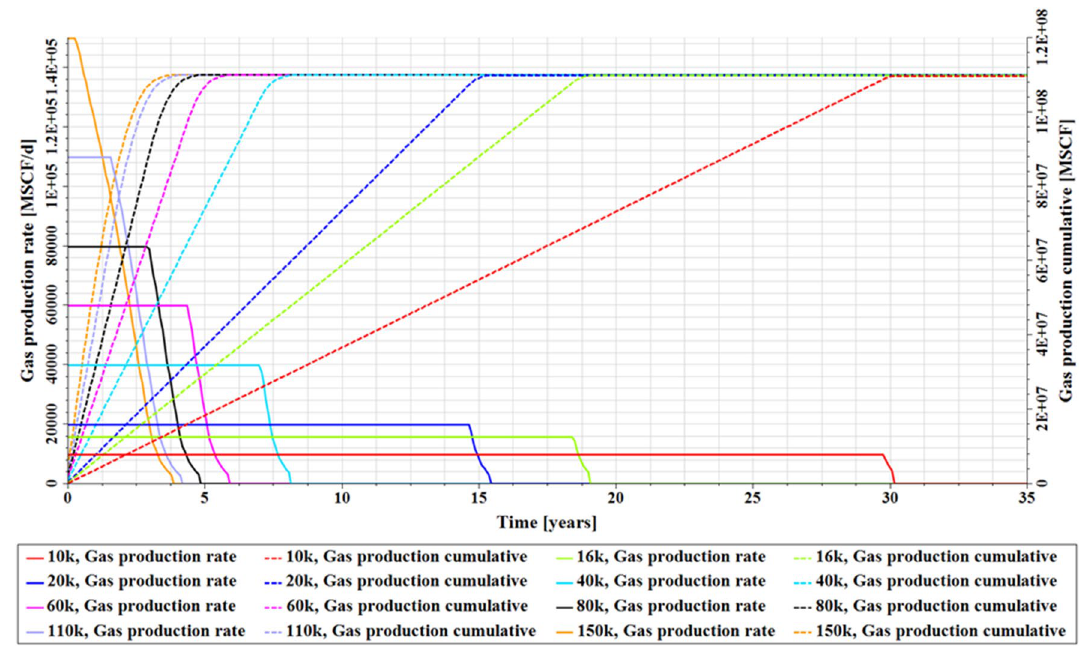
Fig. 18 Gas productions vs. time for different gas production rates